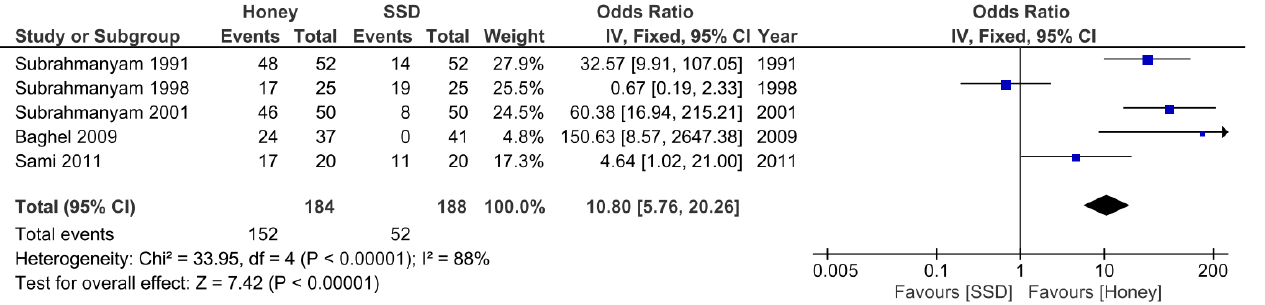
Figure 3. Forest plot of the proportion of wounds rendered sterile at day 7 between honey and SSD burn dressing groups. Green squares = weighted mean difference. Black diamond = overall weighted mean difference.